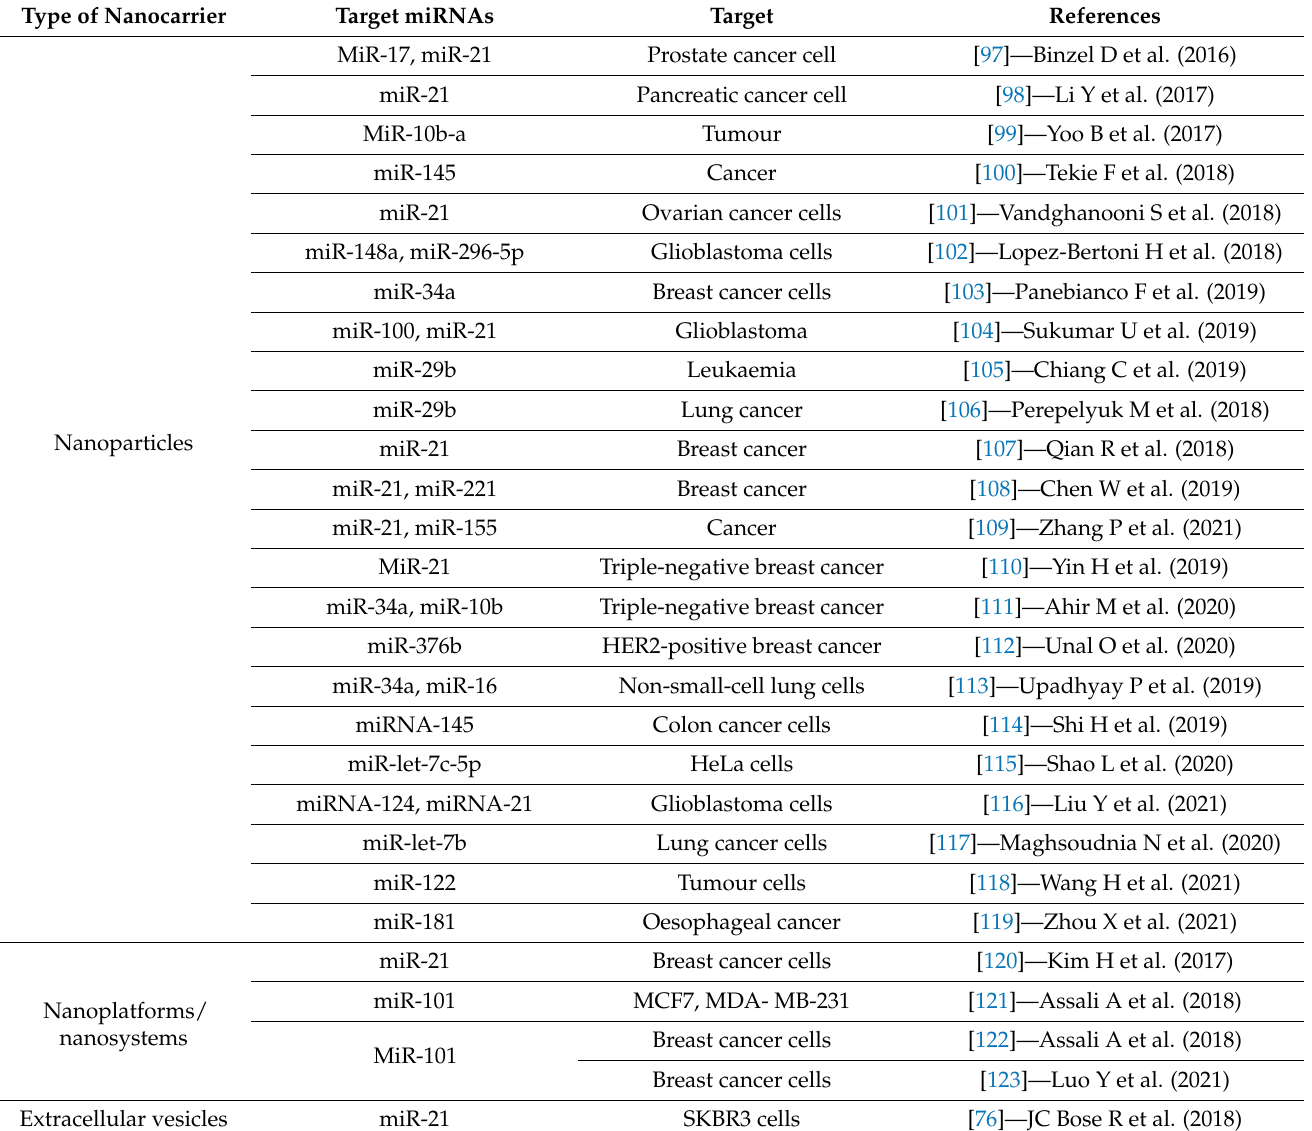
Table 2. miRNAs for